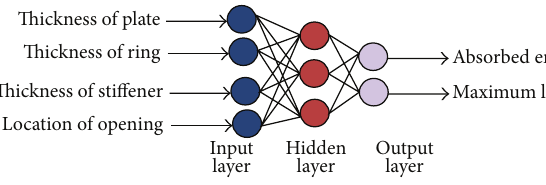
Figure 3: Architecture for the proposed MLP model.